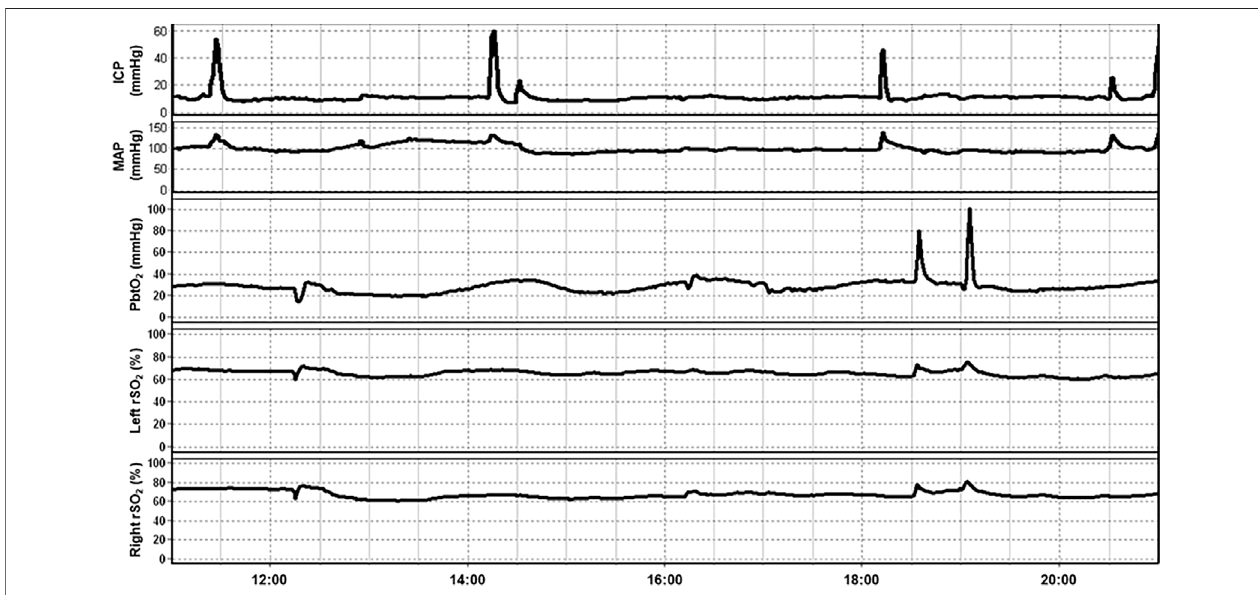
FIGURE 2 | An example of continuous 10-h recording of mean arterial pressure (MAP), intracranial pressure (ICP), brain tissue oxygenation (PbtO 2 ), and regional cerebraloxygensaturation(rSO 2 )inatraumaticbraininjurypatient.Notethat fl uctuationinrSO 2 tendstooccurpriortoassociated fl uctuationsinPbtO 2 .Datatakenfrom previously published and approved studies (University of Manitoba REB: H2017:181, H2017:188 and H2020:118; Bernard et al., 2020; Froese et al., 2020b, 2020a, 2021; Thelin et al.,